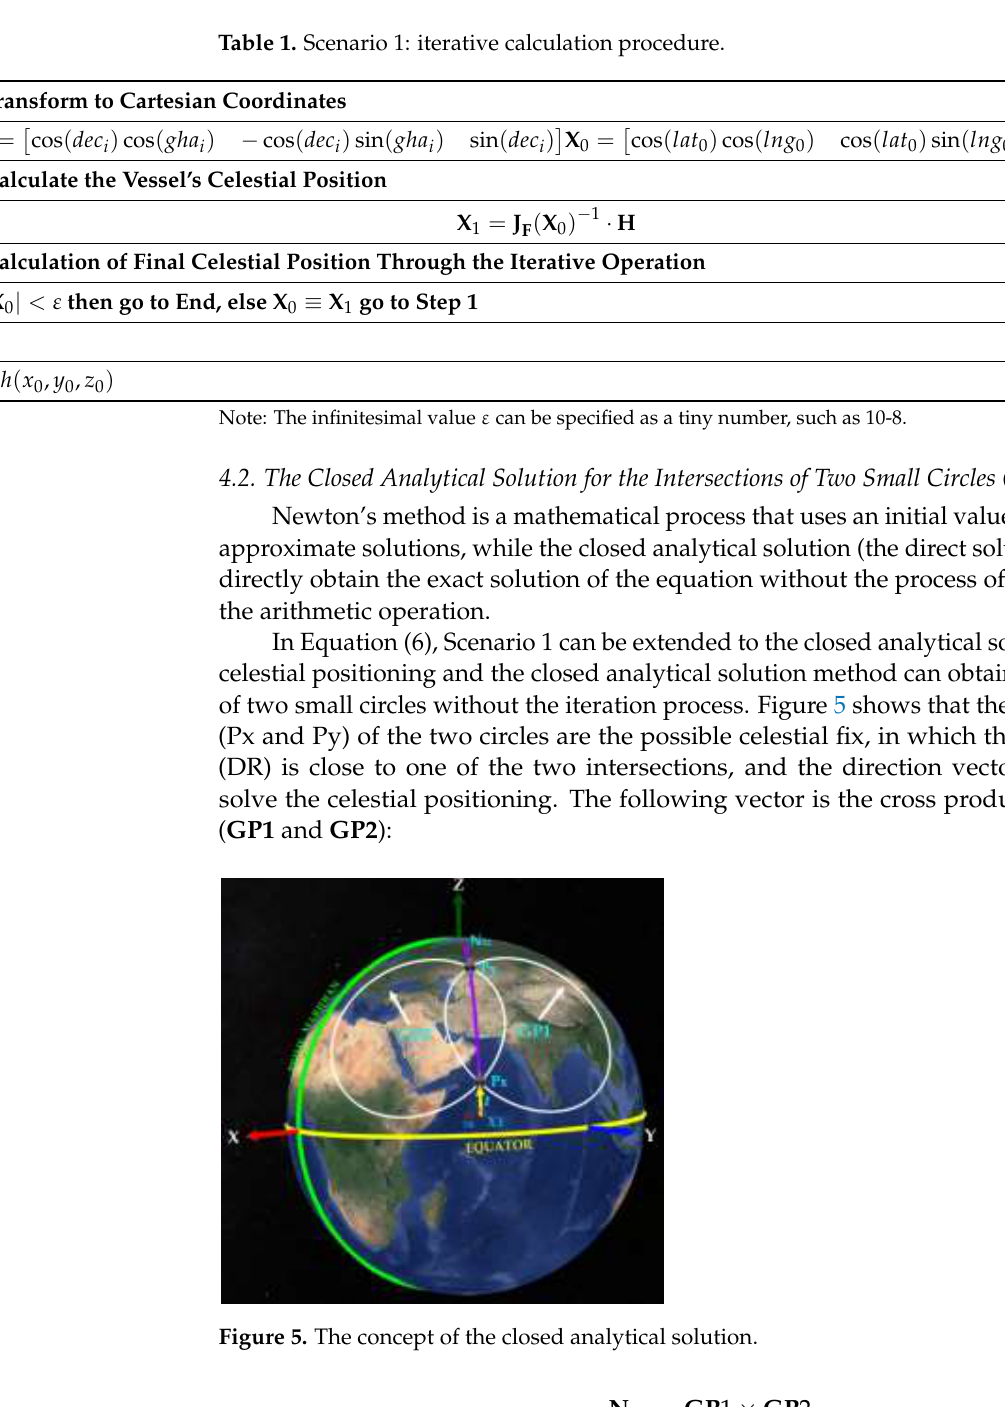
Table 1. Scenario 1: iterative calculation procedure.